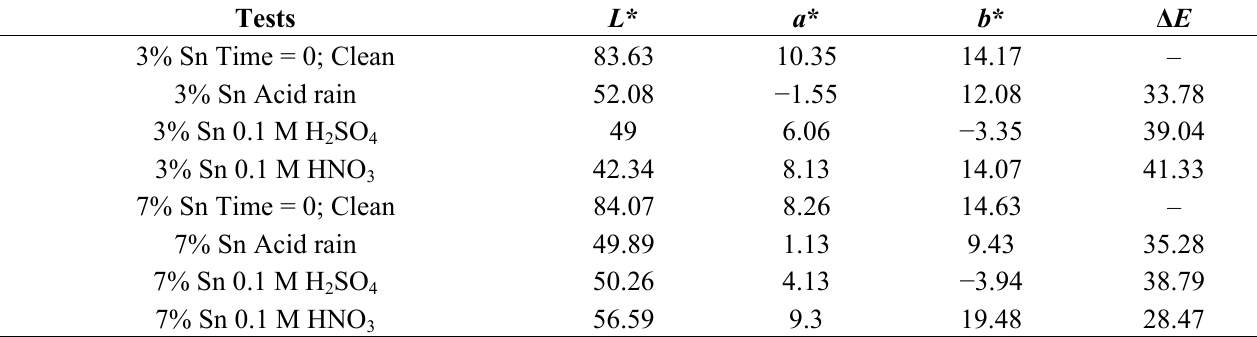
Table 4. Color parameters L * (lightness), a * (red–green component), and b * (yellow–blue component) of the bronzes before and after the immersion testing listed along with Δ